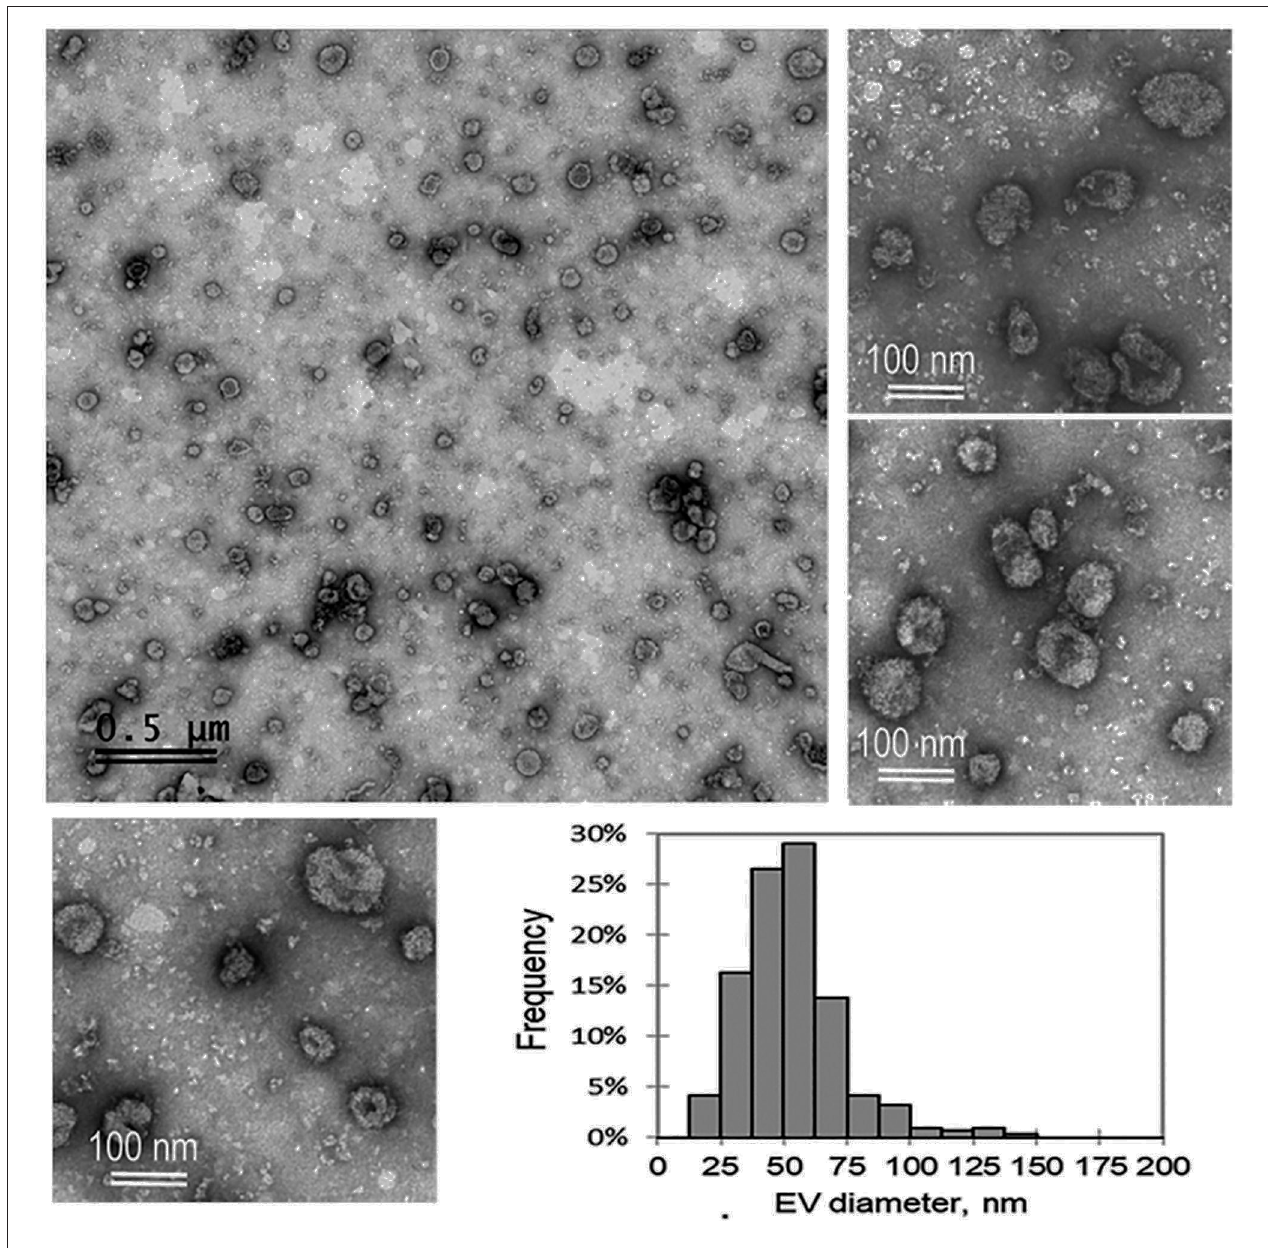
FIGURE 1 | A representative transmission electron microscopy images of bovine exosome-like follicular fluid extracellular vesicles (ffEVs) derived from 3–6-mm ovarian bovine follicles and a histogram of the size distribution of ffEVs are shown.